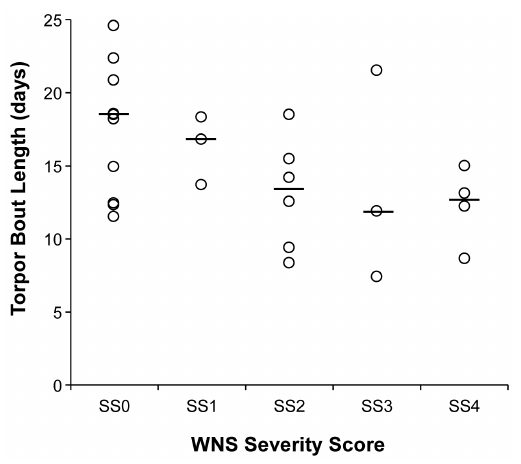
Figure 4. Torpor bout length (TBL) as a function of WNS severity score. Wing tissue was assigned a disease severity score (SS0 to SS4) based upon histology, as follows: SS0= no fungi suggestive of WNS; SS1= occasional but limited superficial fungal infection; SS2= more extensive superficial fungal infection with limited invasion; SS3= more extensive fungal infection with frequent cupping erosions; and SS4= severe fungal infection with deep tissue invasion. Details of the scoring system can be found in Appendix S2 and scores 1 through 4 were identified as WNS. Individual data points are shown as open circles, the median is indicated by a line. As severity of infection increased, torpor bout length significantly decreased (bats aroused more frequently from